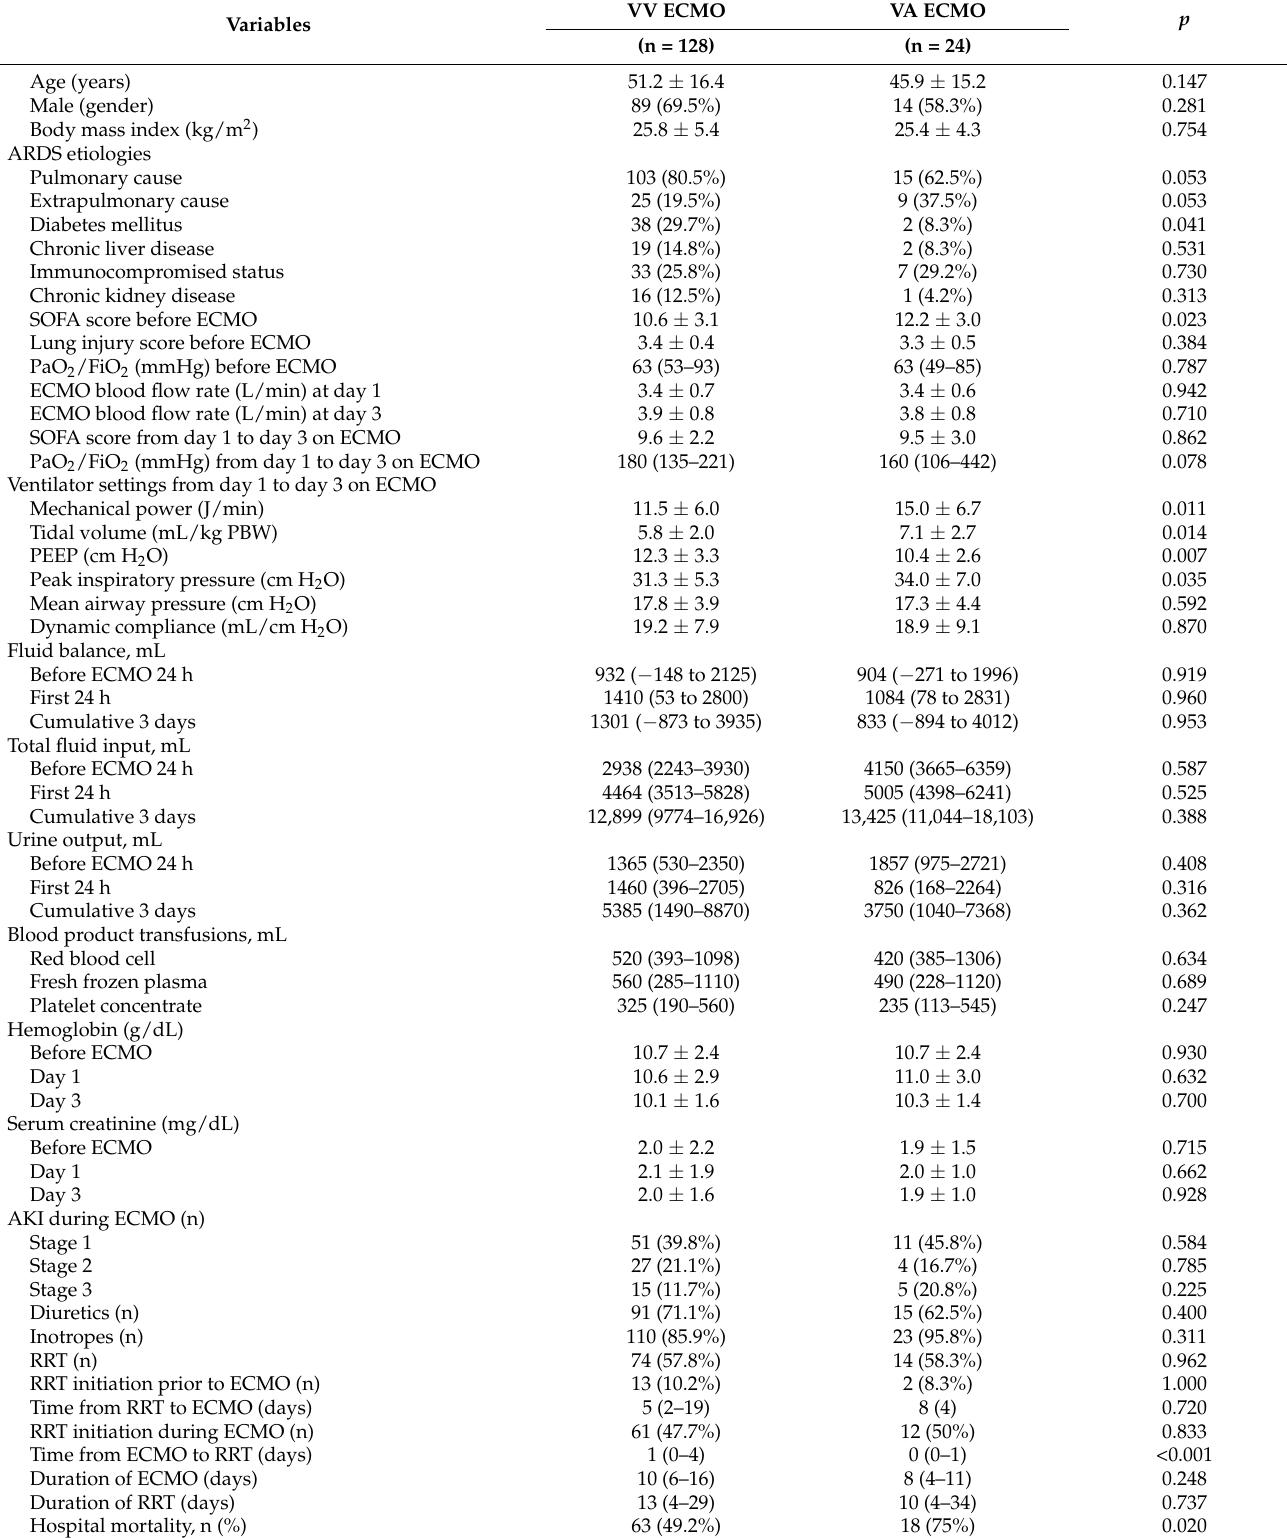
Table 5. Background characteristics and clinical variables: VV-ECMO- and VA-ECMO-supported ARDS